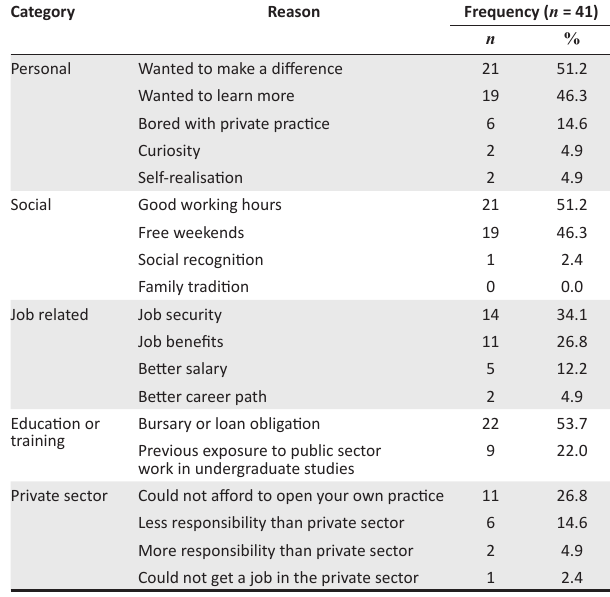
TABLE 2: Ranking of reasons why optometrists choose to work in the public